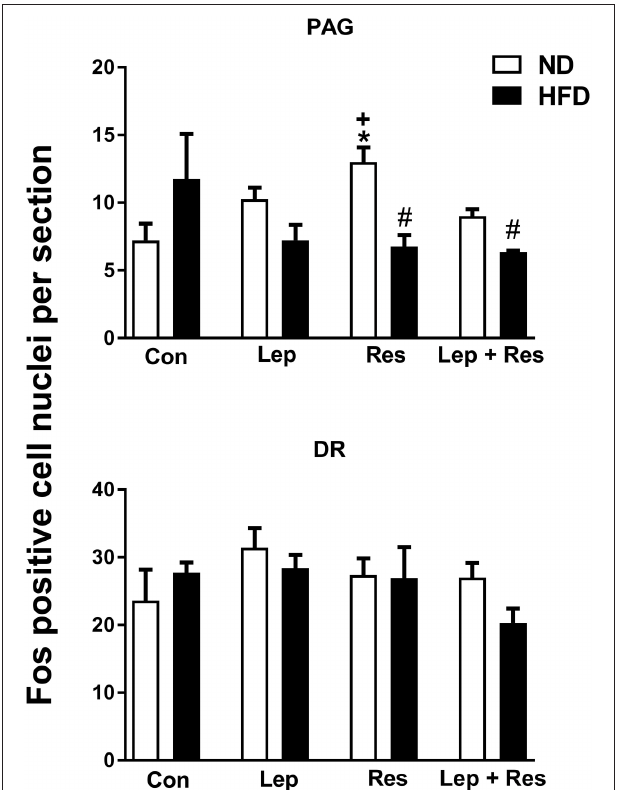
FIGURE 4 | Numbers of Fos-positive cell nuclei counted unilaterally per section in the periaquaductal gray (PAG) and Dorsal raphe (DR) from rats fed a normal chow (ND) and a high fat diet (HFD) administered intracerebroventricular saline (control, n = 4 ND, n = 4 HFD; 5 µ l), leptin ( n = 4 ND, n = 5 HFD; 7 µ g in 5 µ l), resistin ( n = 4 ND, n = 4 HFD; 7 µ g in 5 µ l), or leptin combined with resistin ( n = 5 ND, n = 6 HFD). * P < 0.005 compared with control. # P < 0.005 HFD compared to ND. + P < 0.05 hormone alone compared with leptin +